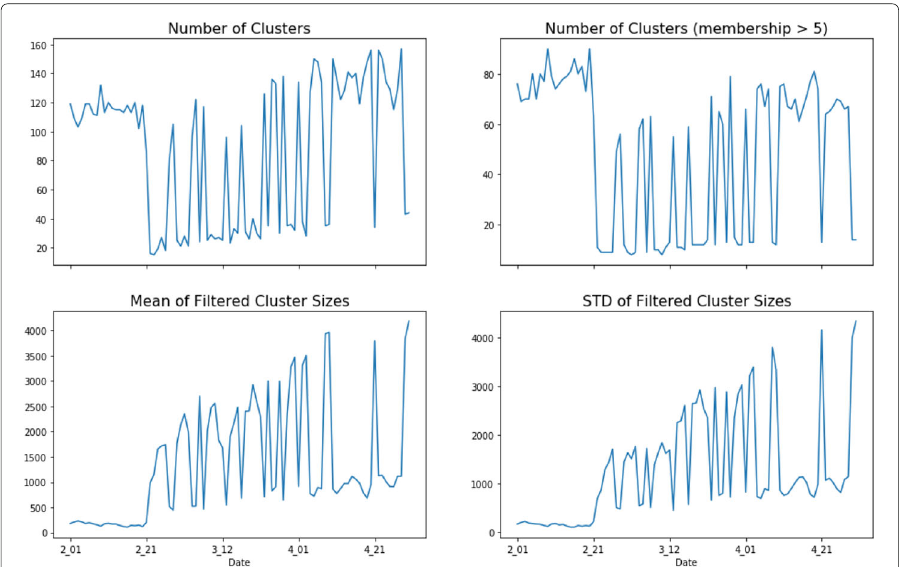
Fig. 3 Daily clustering statistics on clusters produced by the MVMC technique on four views of the hashtags. The daily clusters display three different, temporal patterns of